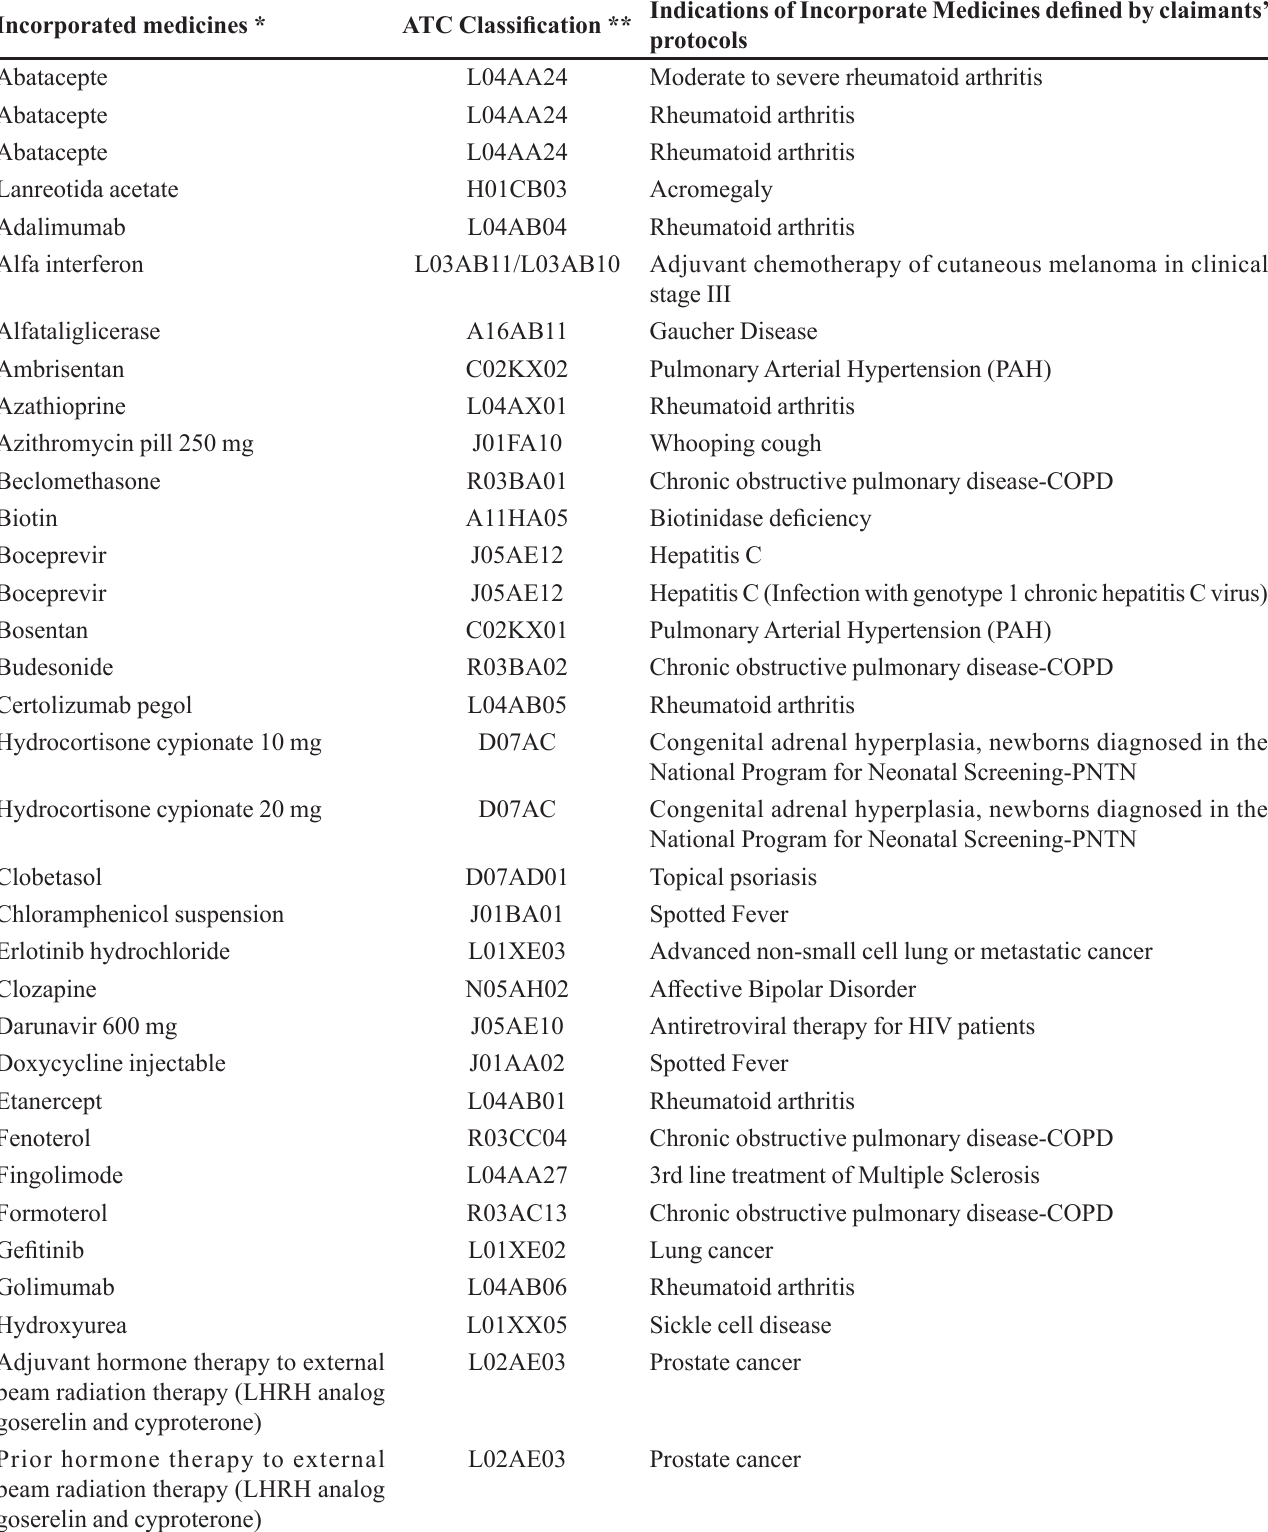
TABLE III - List of medicines incorporated by CONITEC with the respective 5 th level ATC classification and its indications to the National List of Essential Medicines (RENAME). January 2012 - July 2015, Brazil Incorporated medicines